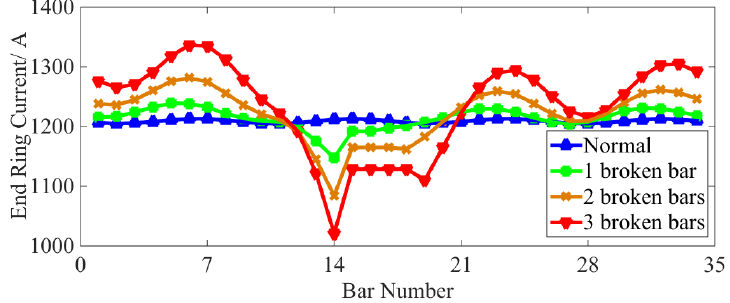
Figure 7. Current change in each end ring.